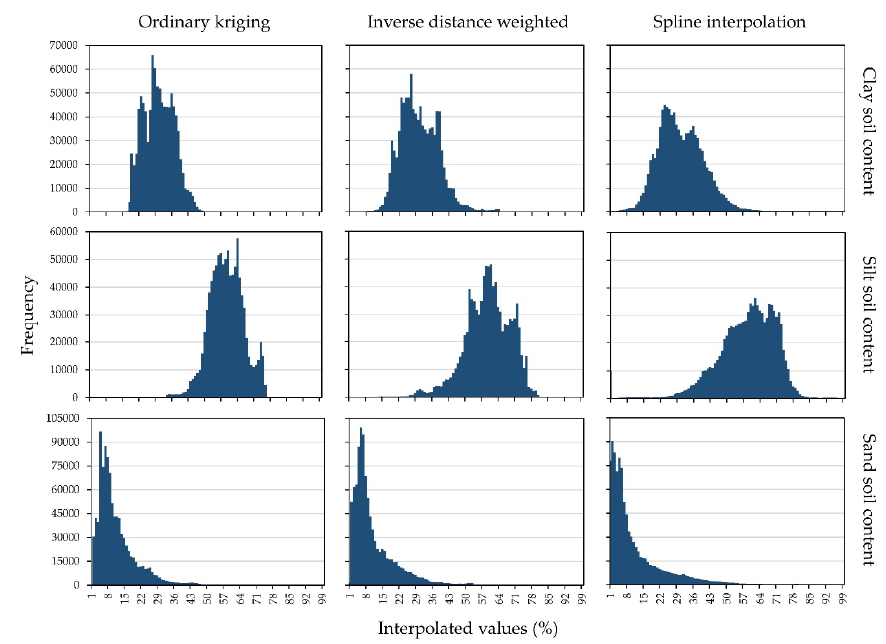
Figure 8. Histograms of interpolation results per soil texture parameter using full sample sets.